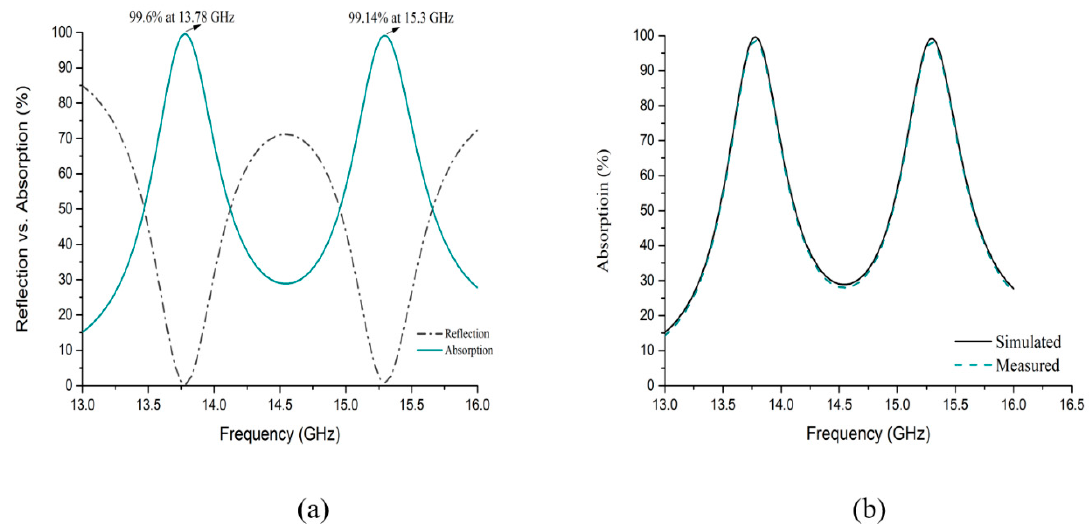
Figure 7. ( a ) reflection vs. absorption performance, ( b ) simulated and measured absorption of proposed MM absorber.